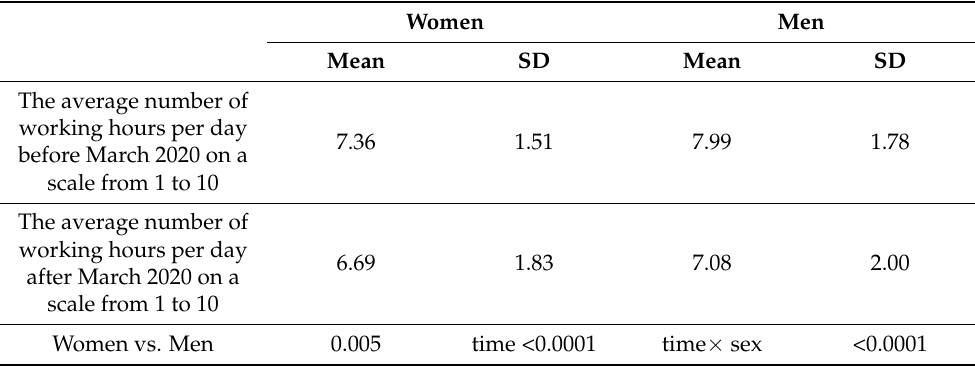
Table 6. Working hours before and during the pandemic.